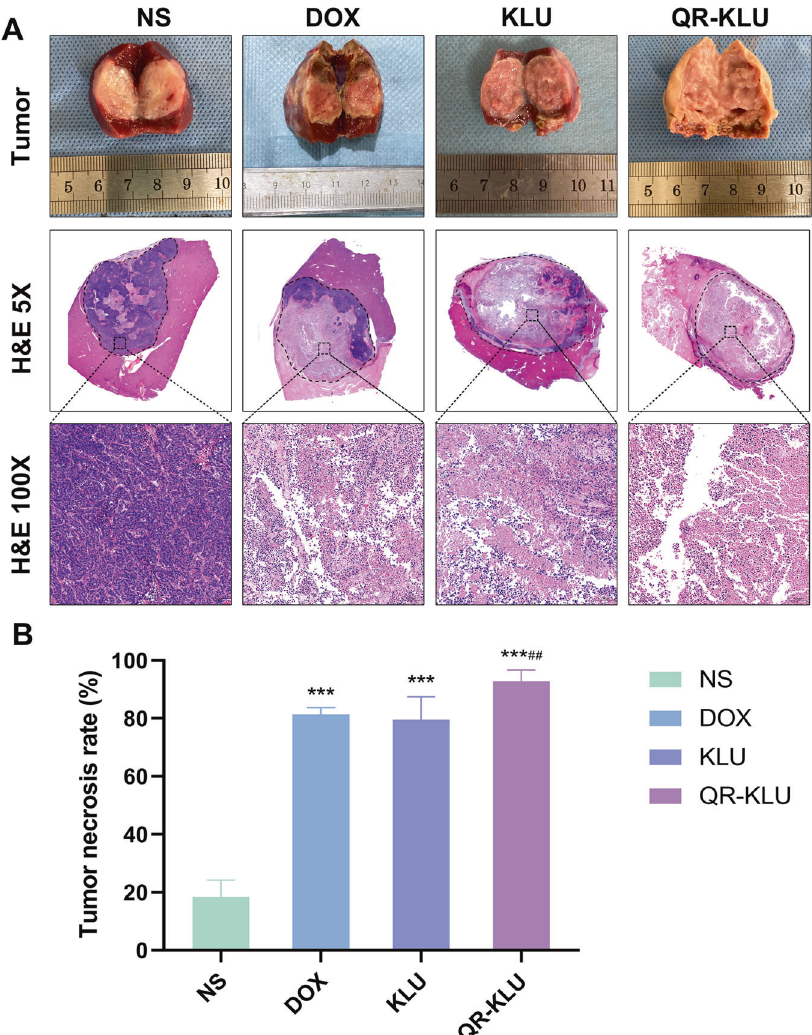
Fig. 5 Peptide QR-KLU promotes tumor necrosis. A Representative pictures of the liver tumors and haematoxylin and eosin (H&E) staining of tumor tissue at 7 days after TACE treatment in NS, DOX, KLU and QR-KLU groups. B Tumor necrosis rates in NS, DOX, KLU and QR-KLU groups. *** P < 0.001 versus NS group, ## P < 0.01 versus DOX